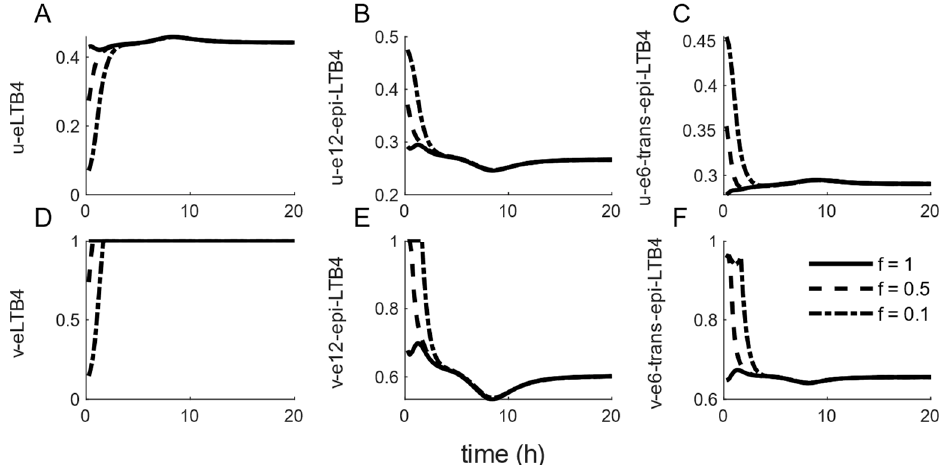
Figure 7. Gene knockdown perturbation profiles for LTs branch for cybernetic control variable u LT ( A – C ) cybernetic control variable v LT ( D – F ). For LTB 4 , its associated cybernetic variables u -eLTB 4 ( A ) and 𝑣 -eLTB 4 ( D ) decrease initially because of the downregulation of its flux due to decreased enzyme Ltbd4h (eLTB 4 ). The enzyme synthesis variables u -e12-epi-LTB 4 ( B ) and u -6t-epi-LTB 4 ( C ), however, increase in response because the 𝑢 (cid:3013)(cid:3021) for all the LTs metabolites in the branch (cid:3284) (LTB4, 12epi-LTB 4, and 6t-epi-LTB 4 ) sum to 1. The increased flux of 12epi-LTB 4 and 6t-epi-LTB 4 also results in an increase in 𝑣 -e12-epi-LTB 4 ( E ) and 𝑣 -6t-epi-LTB 4 ( F ) initially.